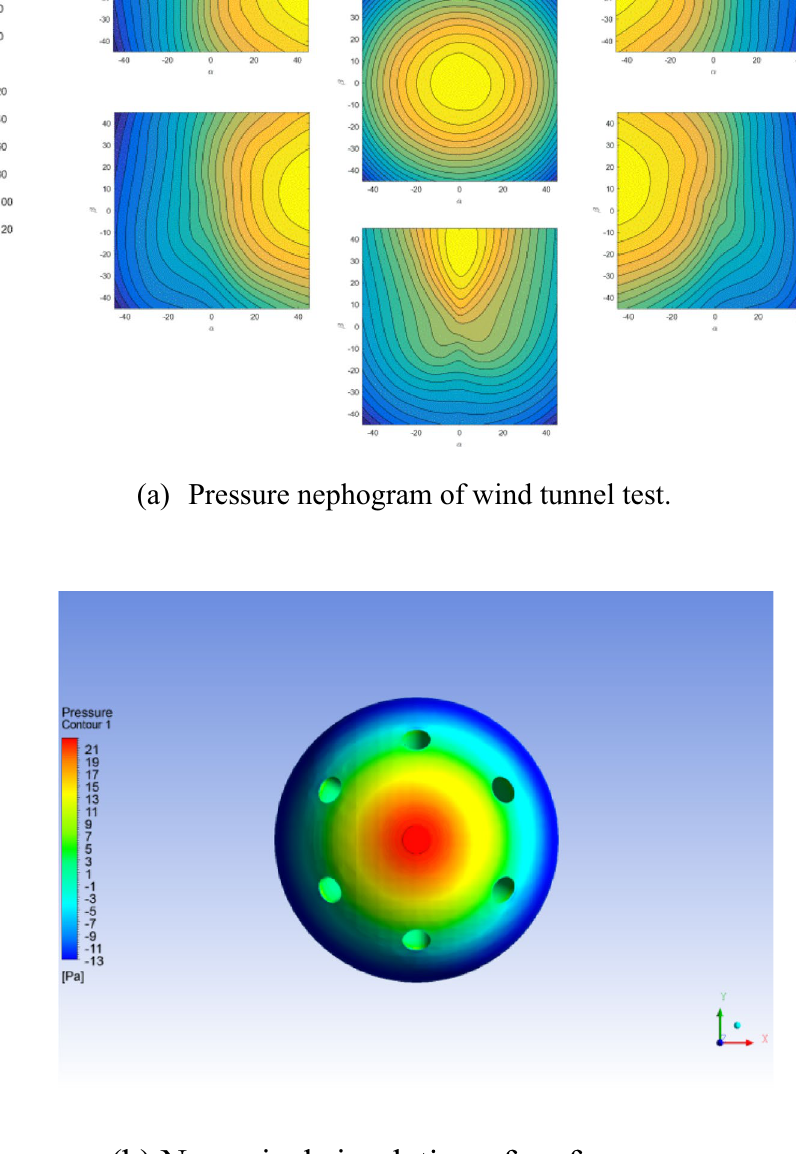
Figure 10. Pressure nephogram of the 7-hole probe experimental data and numerical